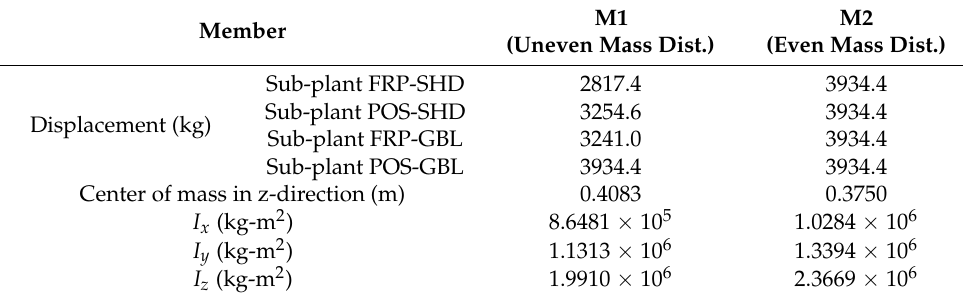
Table 3. Mass information according to two mass distribution